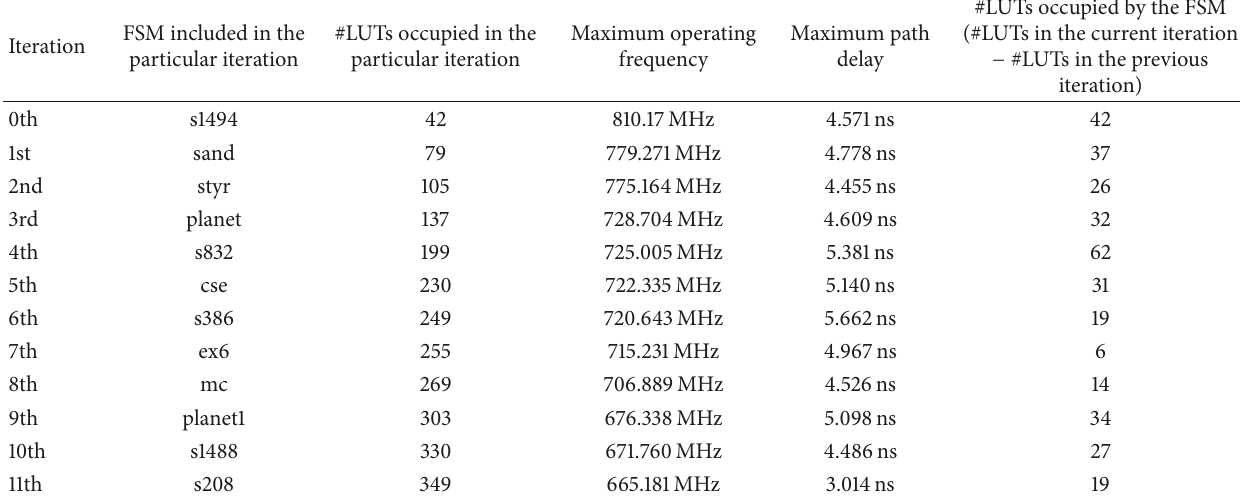
Table 4: Iterative implementation of the Reconfigurable FSMIM-S architecture on Virtex-6.